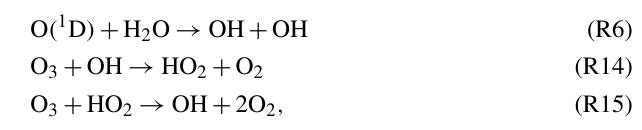
mountains and on the windward side of the slope. At higher altitudes, the negative segregation intensity